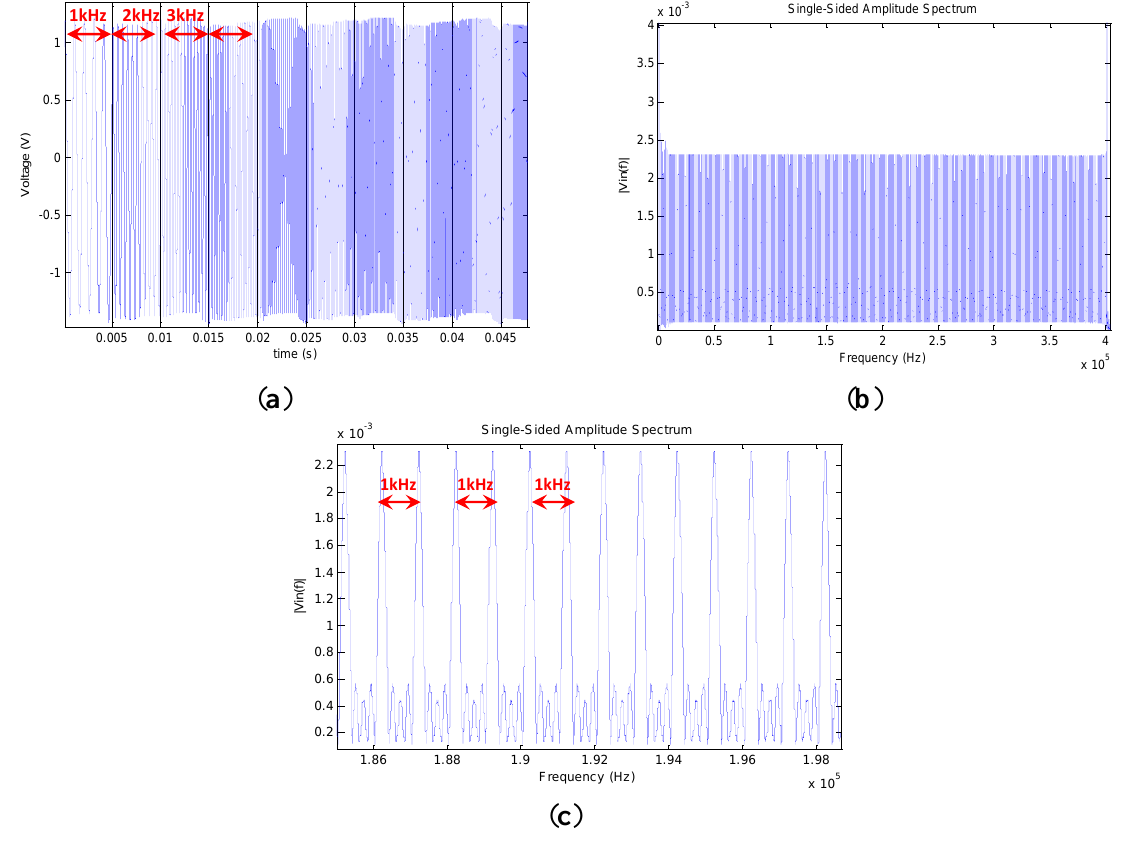
Figure 12. ( a ) Zoom onto the excitation signal. Notice that we can distinguish after each 5 ms the incrimination of the frequency. ( b ) Spectral response of the excitation frequency. ( c ) Zoom onto the spectral response of the excitation signal between 186 kHz and 198 kHz. Notice that the spikes are equidistant and have the same